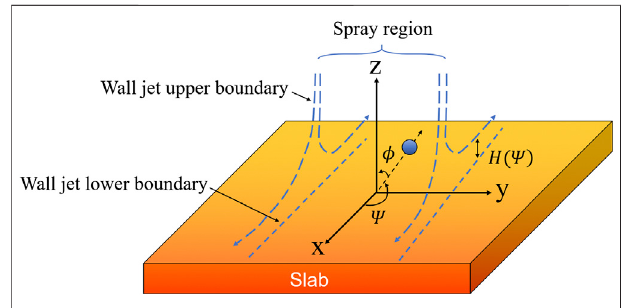
FIGURE 5 | Illustration of wall-jet impingement